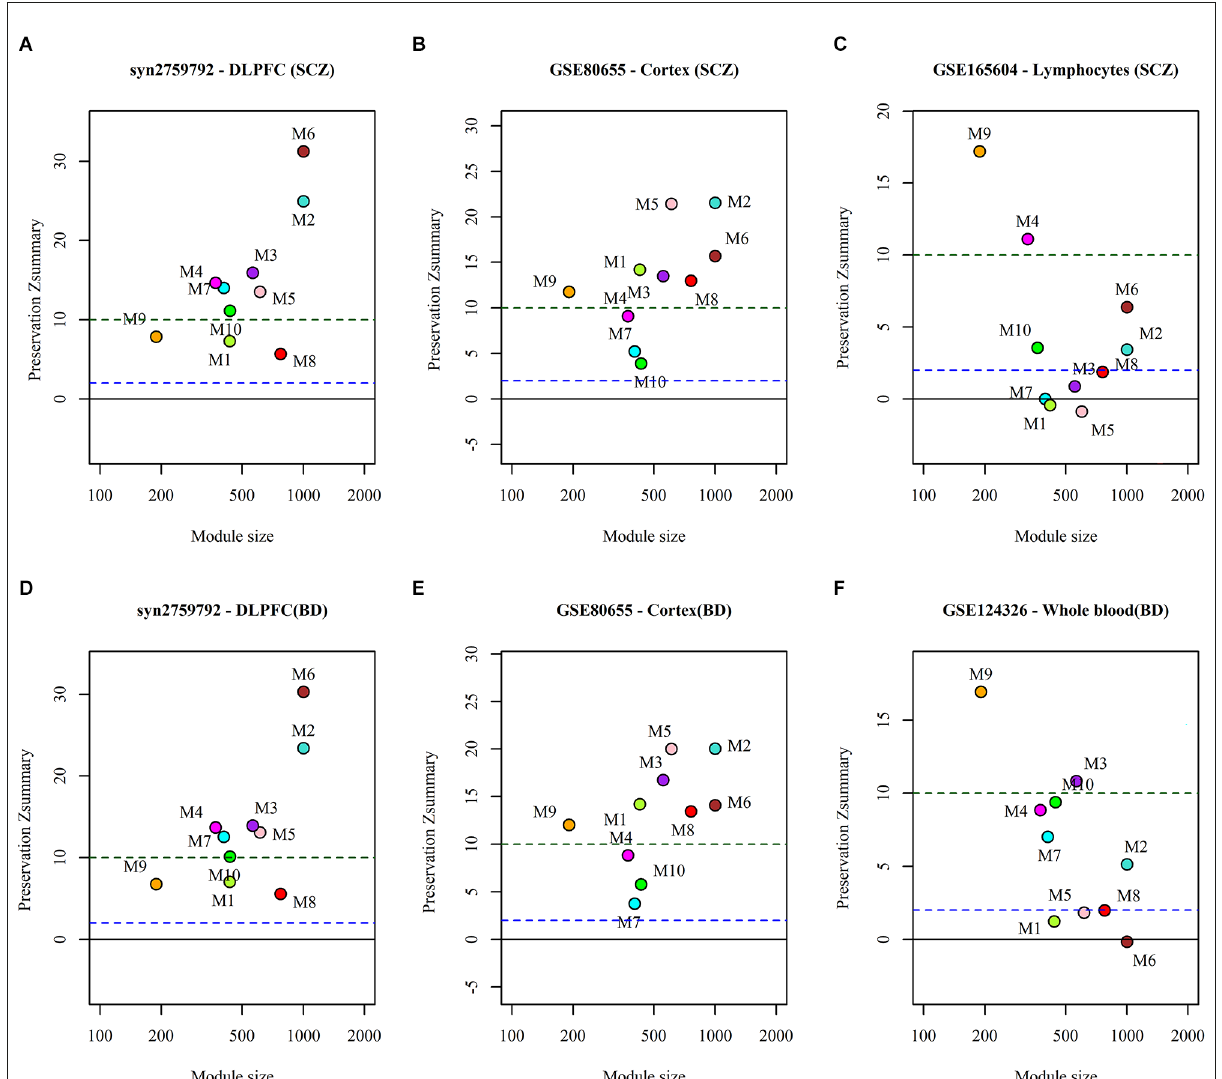
FIGURE5 The preservation of miRNA sponge modules in the post-mortem brain and blood-based datasets of SCZ (top panel: A,B,C ) and BD (bottom panel: D,E,F ).